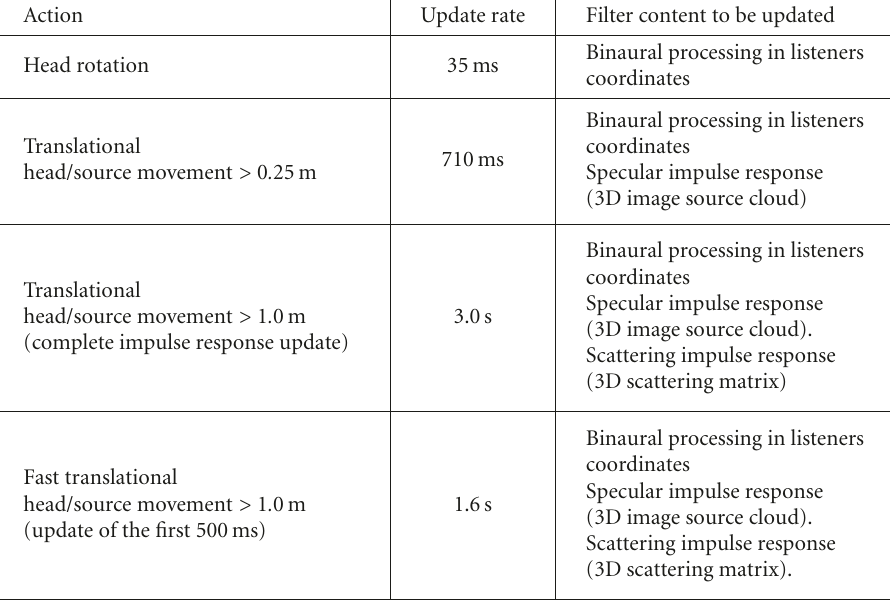
Table 5: Update intervals for di ff erent modes and conditions of head or source movements based on the measurements shown in Table